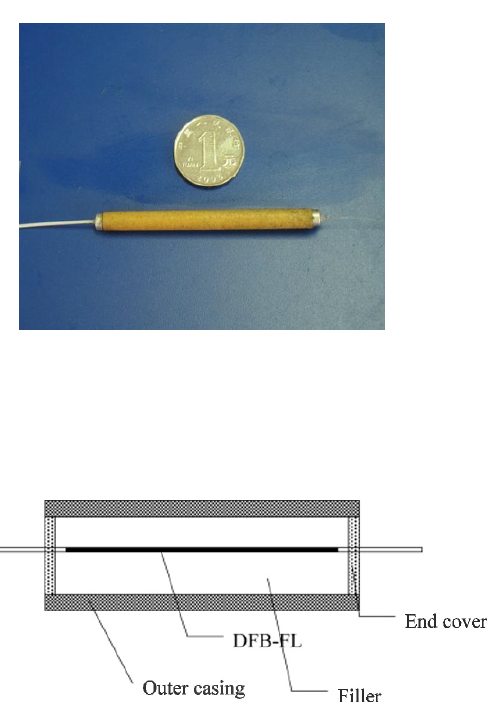
Fig. 2 Fiber laser hydrophone’s sensitivity test system.